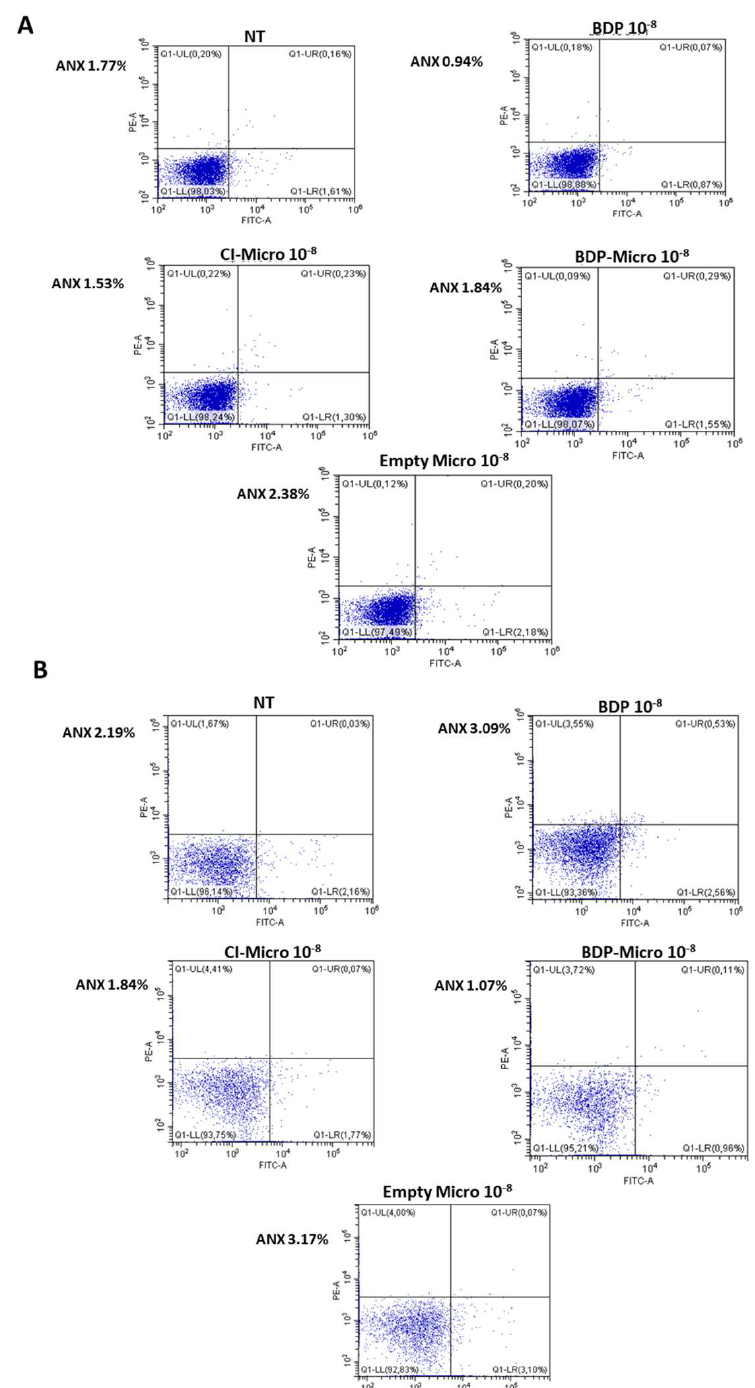
Figure 6. Cell apoptosis in 16HBE and A549 cells. 16HBE ( A ) and A549 ( B ) cells were incubated with the drug (10 −8 M, free or entrapped into CI-Micro or BDP-Micro) for 1 h before the CSE and LPS stimulation. Cell apoptosis was assessed by staining with annexin V–propidium iodide (PI). Representative dot slot are shown.